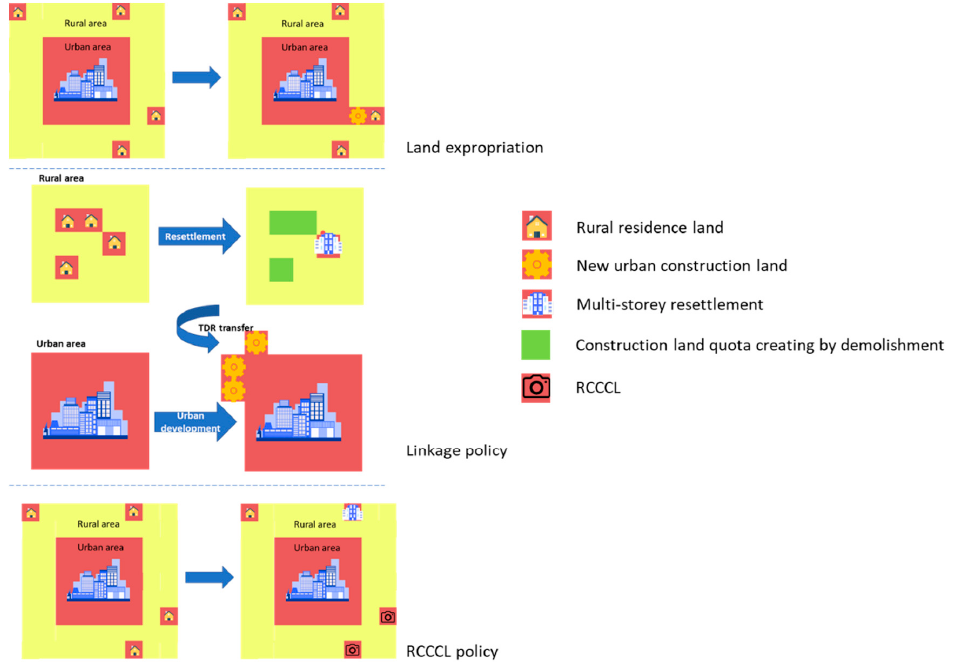
Figure 2. Three approaches to supply construction land.